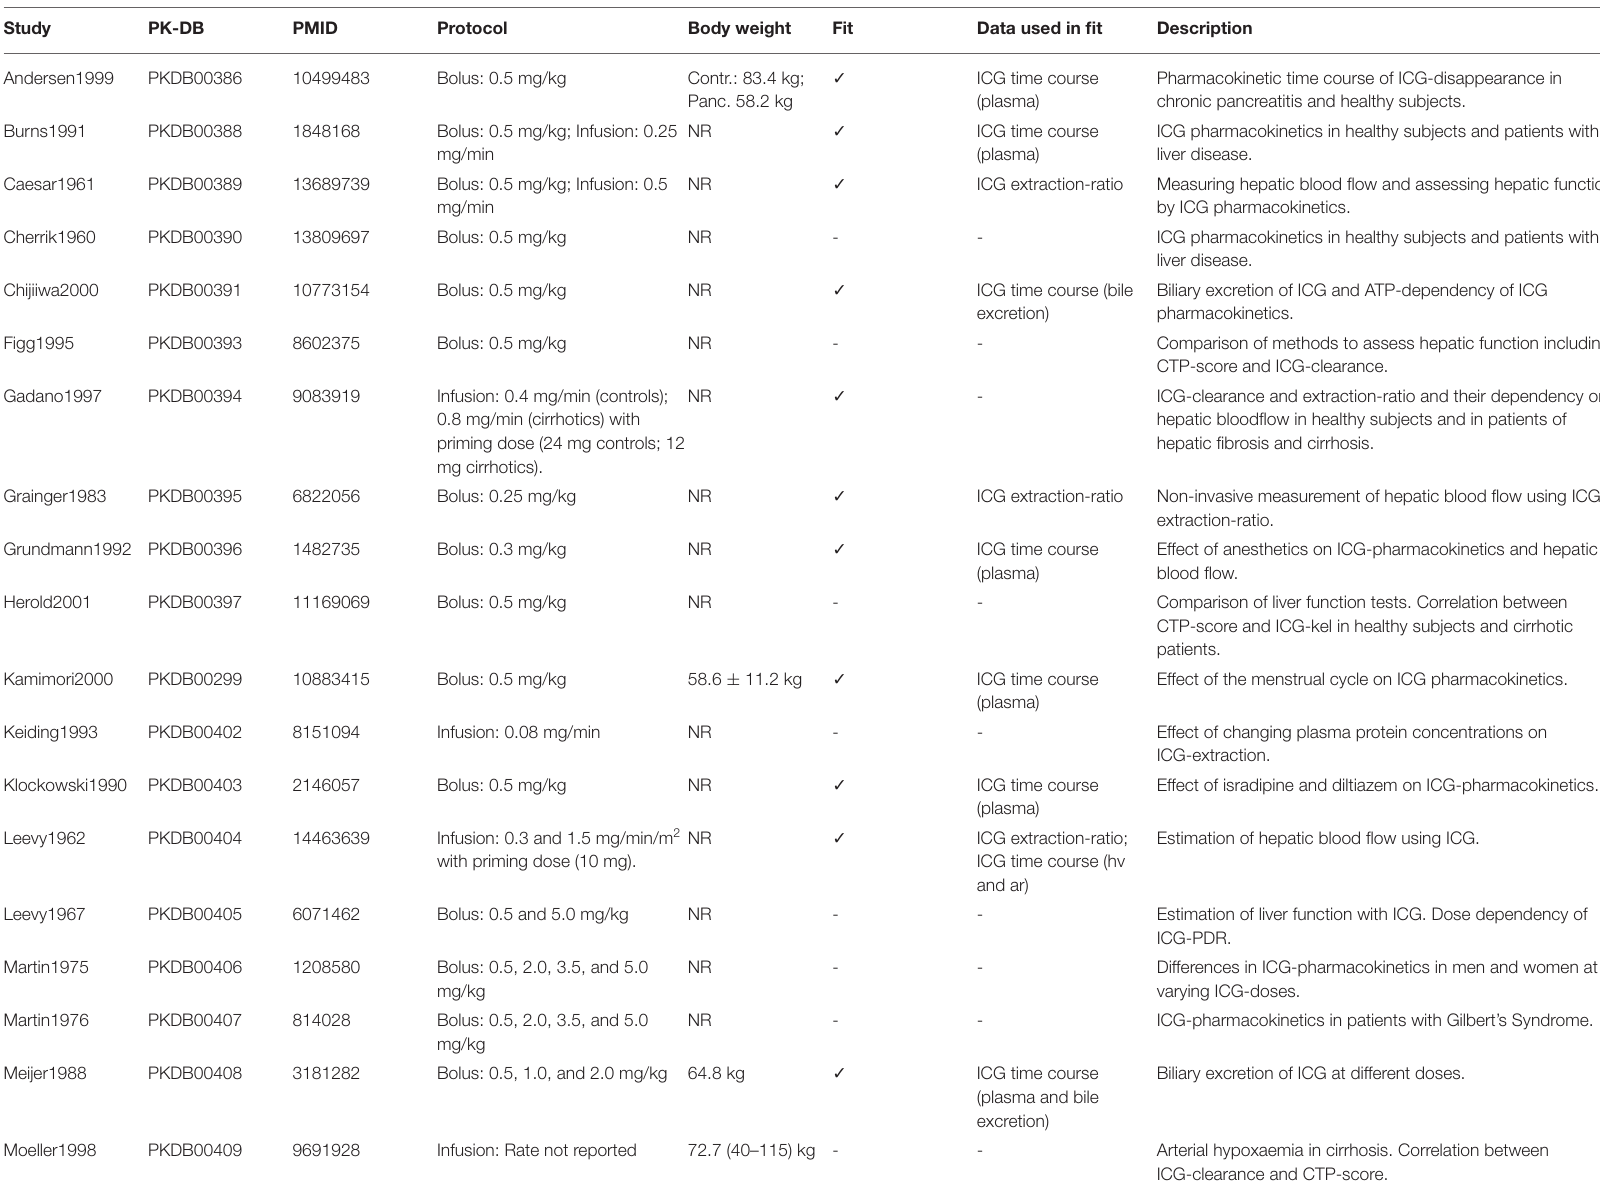
TABLE 1 | Overview of curated clinical studies.